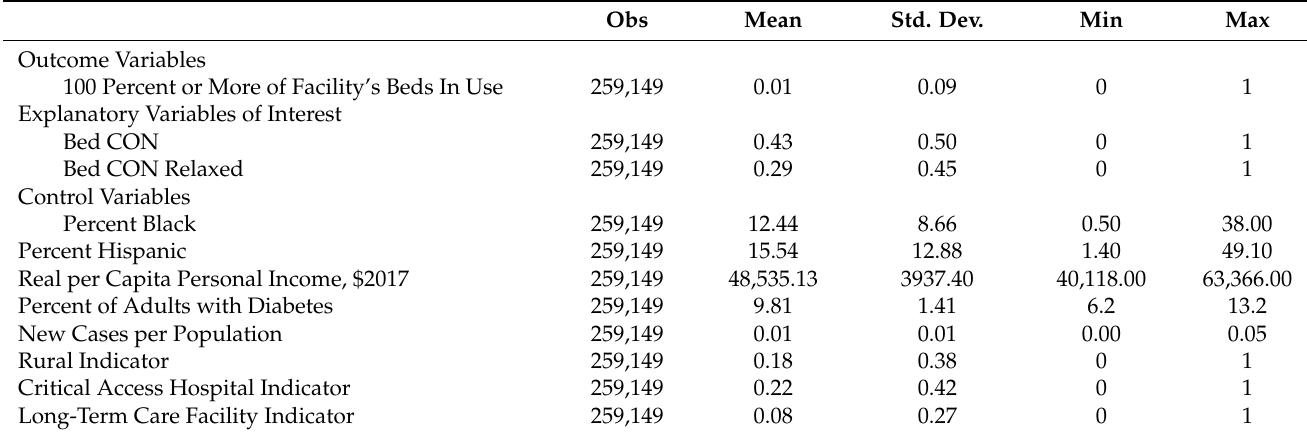
Table 3. Descriptive Statistics, Observations by Hospital and